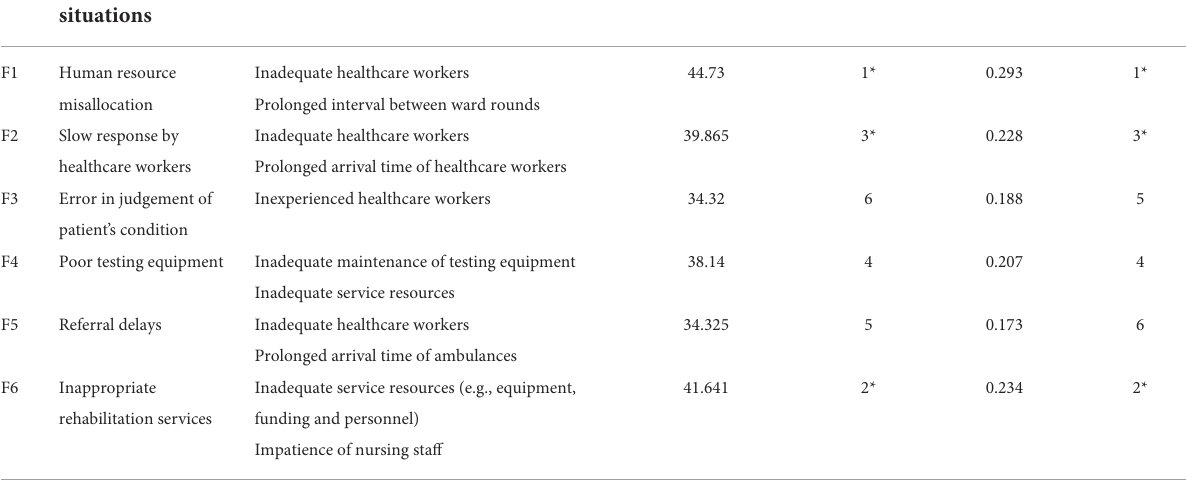
TABLE 10 Comparison of the RPN value and prioritization between traditional and Fuzzy FMEA in the CMEC service model for the elderly.